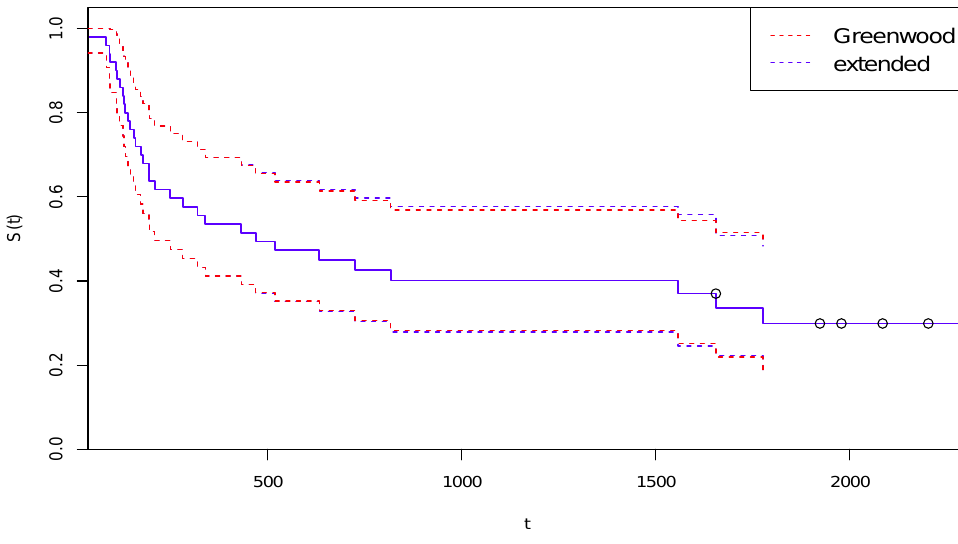
Figure 5. Kaplan–Meier curves estimated by CoDMI with adjustment for censoring and related confidence intervals—Arm